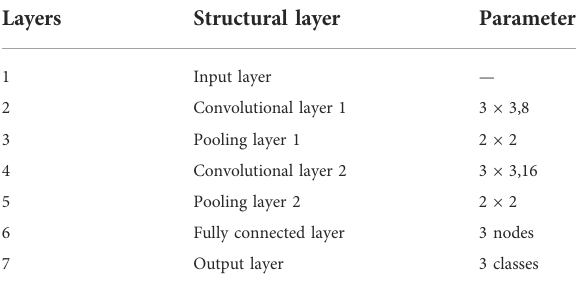
TABLE 9 CNN model structure and parameters. TABLE 10 Identi fi cation performance of different algorithm